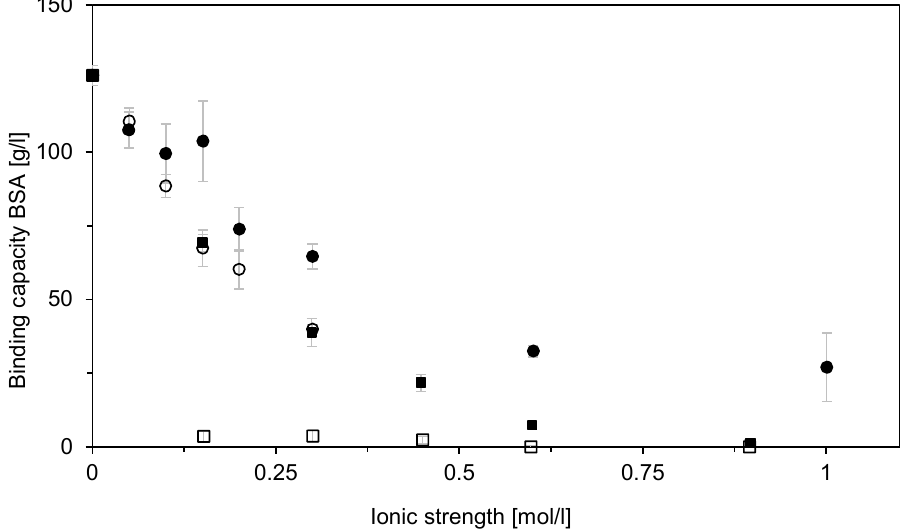
Figure 6. Influence of salt type and ionic strength on single-component adsorption of BSA on Sartobind STIC using a micromembrane module with centrifuge-forced flow at a pH of 8. Symbols represent GuHCl ( ● ), MgCl 2 ( ■ ), NaF ( ○ ), and K 2 HPO 4 ( □ ). Error bars represent standard deviations.